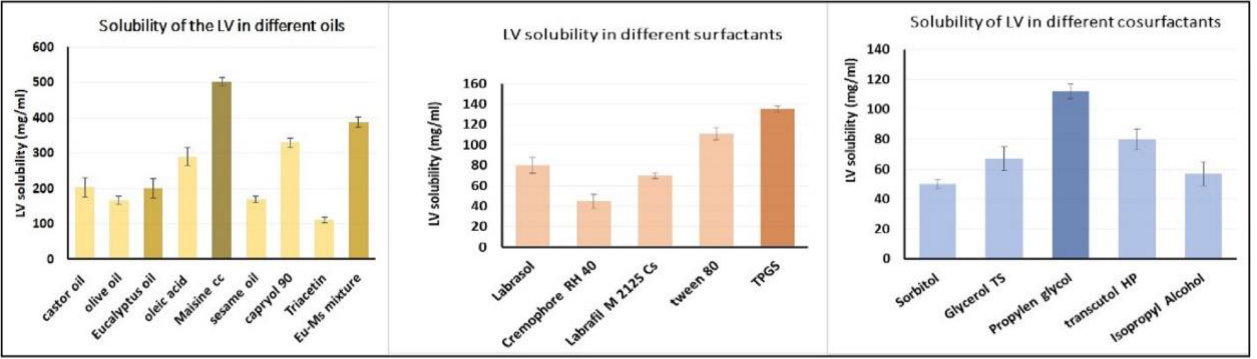
Figure 1. Solubility of LV in different oil phases, surfactants, and co-surfactants.